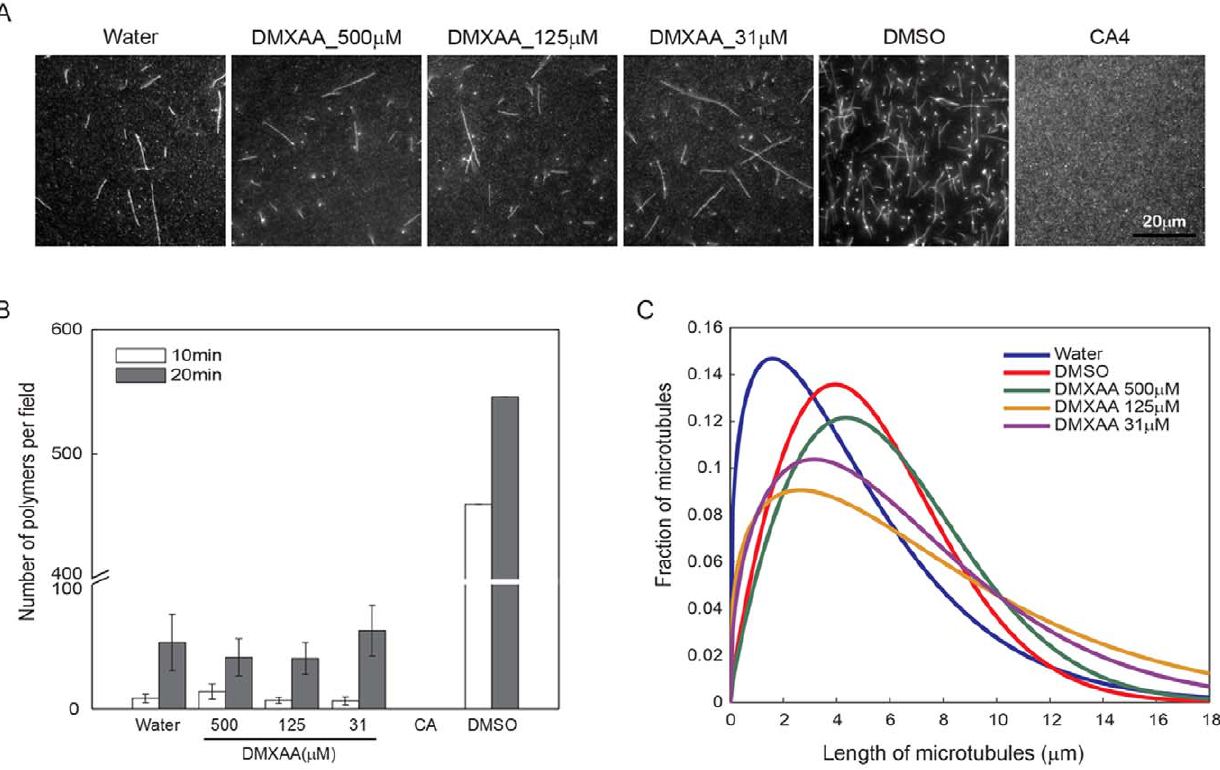
Figure 4. Comparison of the effects of CA4 and DMXAA on tubulin polymerization. Polymerized tubulin was visible by fluorescence microscopy as string like shapes. Various concentrations of DMXAA and its vehicle control (water) showed similar tubulin polymerization rates. DMSO was used as a positive control. The white scale bar indicates 20 m m. All images were taken after 20 min polymerization. (B) The number of polymers per field were counted using ImageJ. Three to ten different random stage positions were counted to measure number of polymers for each condition, except for DMSO treated were one stage position was counted. Error bars were calculated as the standard deviation from the results of 3 independent experiments. (C) The Weibull-parametrized distribution of microtubule length compared across conditions in 20 min polymerization samples. The lengths were measured using ImageJ and fit to a Weibull probability density function for each condition.